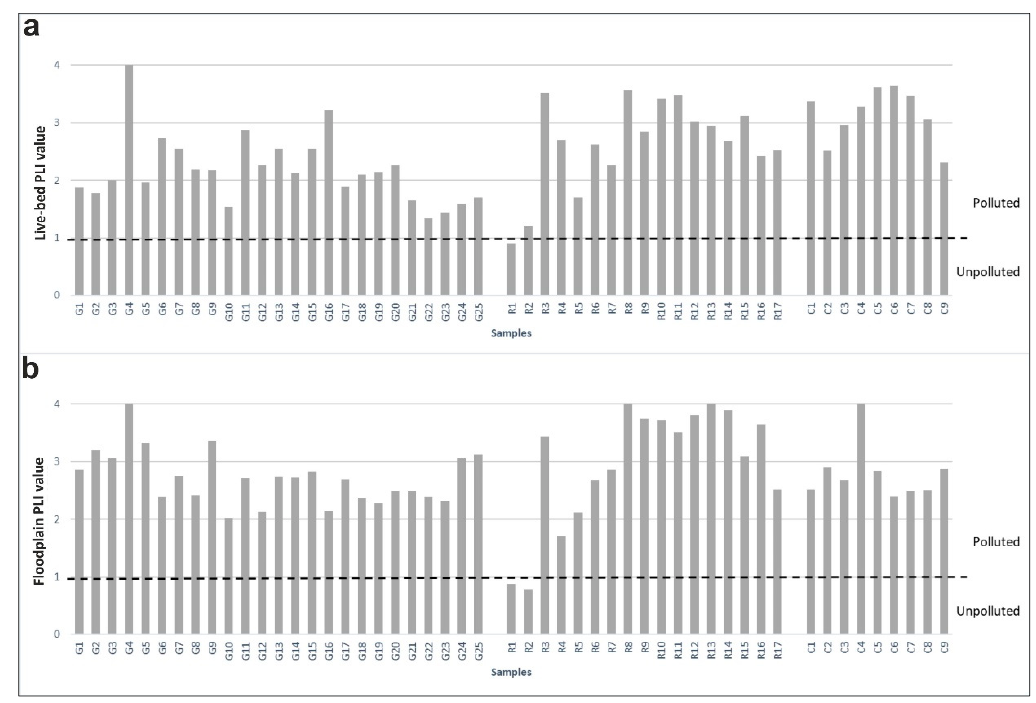
Figure 5. Distribution of pollution load index (PLI) values along the rivers of the La Carolina mining district. ( a )—live-bed PLI value; ( b )—floodplain PLI